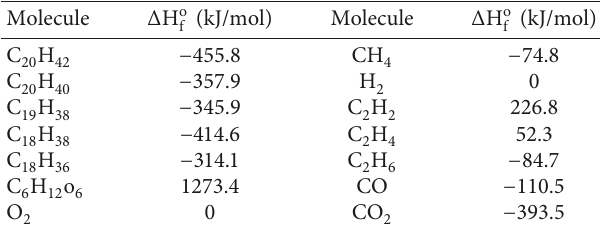
Table 1: Standard enthalpy of formation [6,